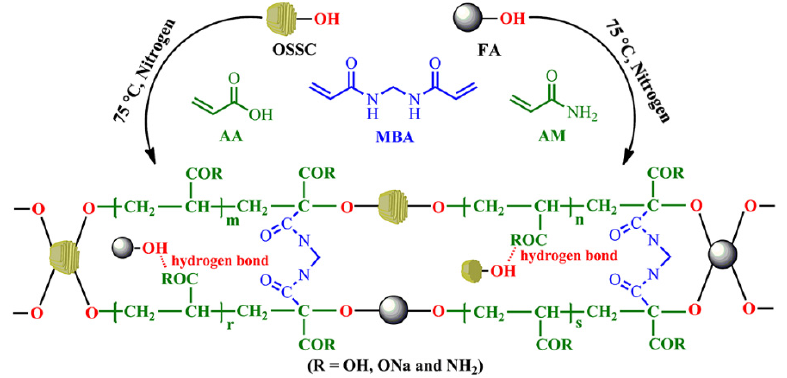
Figure 2. TG ( a ) and DTG ( b ) of PAMFS and